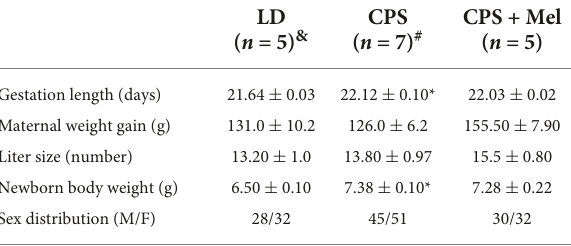
TABLE 3 Effect of gestational chronodisruption and melatonin supplementation on gestation length, maternal weight gain, and newborn variables.